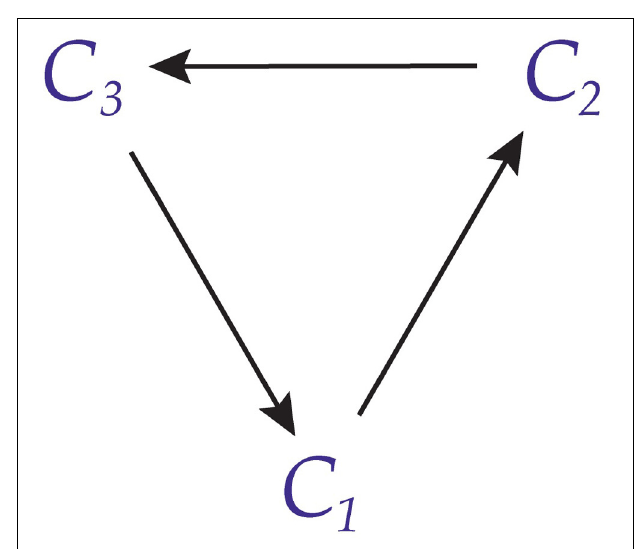
FIGURE 8 | Simplified graph of three conscious agents with directed